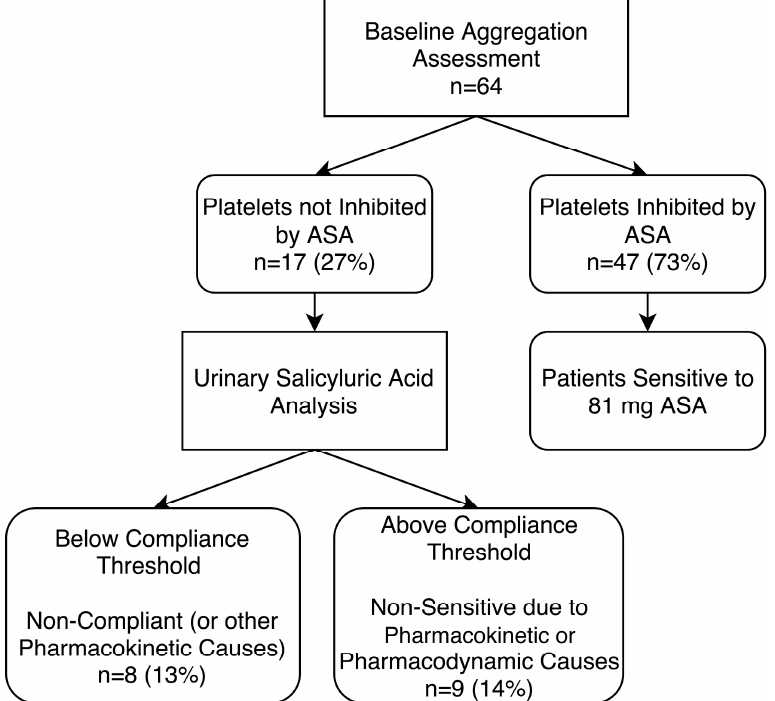
Figure 5. Baseline aggregation testing of patients on 81 mg aspirin (ASA) and urinary salicyluric acid assessment to determine non-compliance or non-sensitivity due to pharmacokinetic or pharmacodynamic causes. Platelets were considered not inhibited by ASA if there was evidence of ≥ 20% maximal platelet aggregation during light transmission aggregometry (LTA) after activation with arachidonic acid. ASA compliance was confirmed by urinary salicyluric acid concentrations >27 µM.